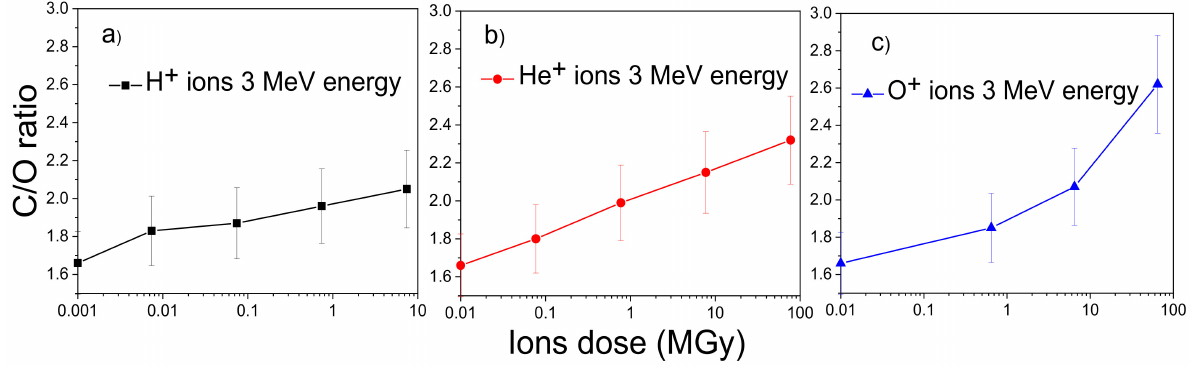
Figure 2. C/O ratio vs. doses released by H + ( a ), He + ( b ) and O + ions ( c ). In Figure 2a, the value for the C/O ratio at about 10 MGy is considered for a better comparison with those obtained at higher doses released by the He + and O + ions. The error in the evaluation of C/O ratio is about 10%. An almost linear relation between the RBS C/O ratio and the absorbed dose is visible, within the experimental error, for all three beams at lower doses than 750 kGy and in the regime of electronic energy deposition. For higher doses the linearity decreases, and a saturation trend appears proportionally to the regime of nuclear energy